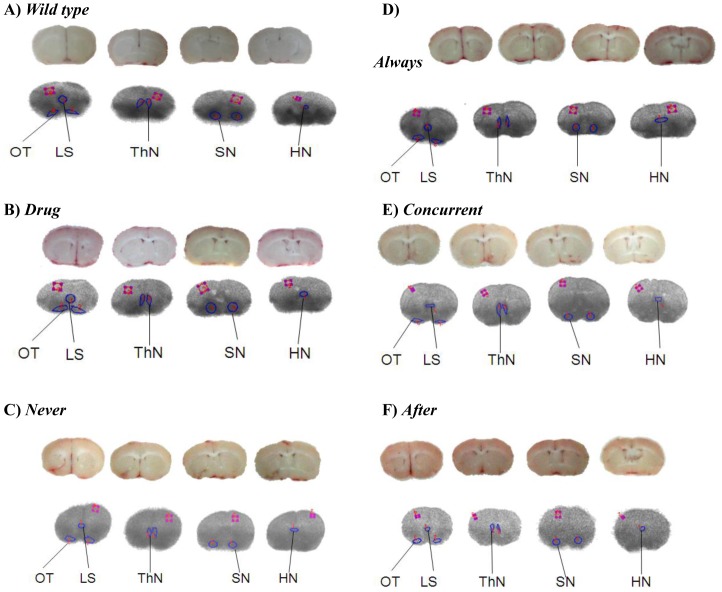
Serotonin transporter determined with [123I]ADAM/ex vivo autoradiography in the brain of CT26/luc tumor-bearing mice.The mouse brain obtained at 90 min post caudal vein injection of 1 mCi/ml [123I]ADAM was performed with ex vivo autoradiography. The top and bottom rows in each subfigure are the anatomy and ex vivo autoradiography, respectively. The blue circle is the target, and the red square is the cortex. (OT  =  olfactory tubercle; LS  =  lateral septal nucleus; ThN  =  thalamic nuclei; SN  =  substantia nigra; HN  =  hypothalamic nuclei).